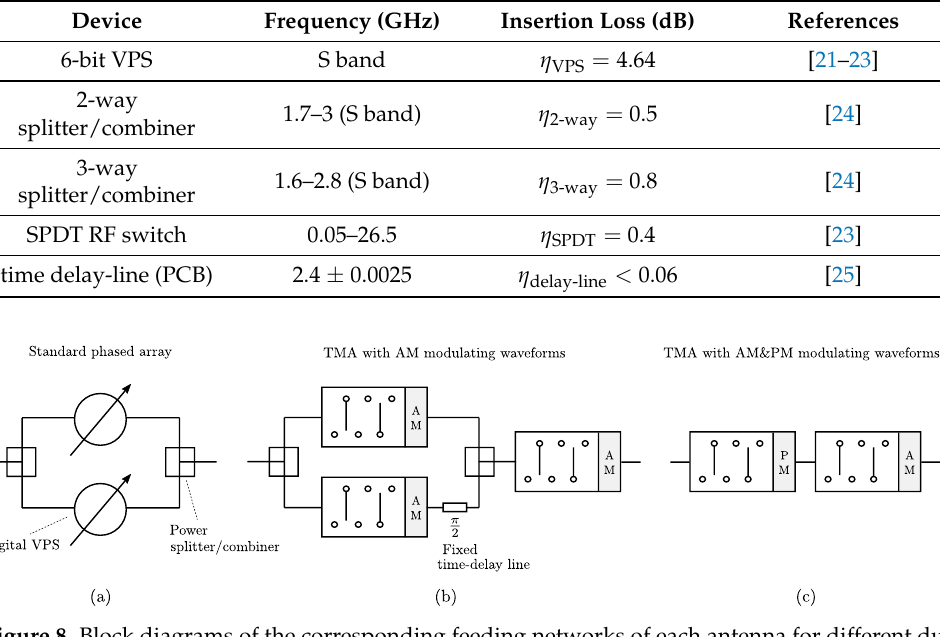
Figure 8. Block diagrams of the corresponding feeding networks of each antenna for different dual- beam steerable array solutions: ( a ) Standard phased array with digital VPSs [26]; ( b ) TMA with AM modulating waveforms [18]; and ( c ) TMA with AM & PM modulating waveforms (this